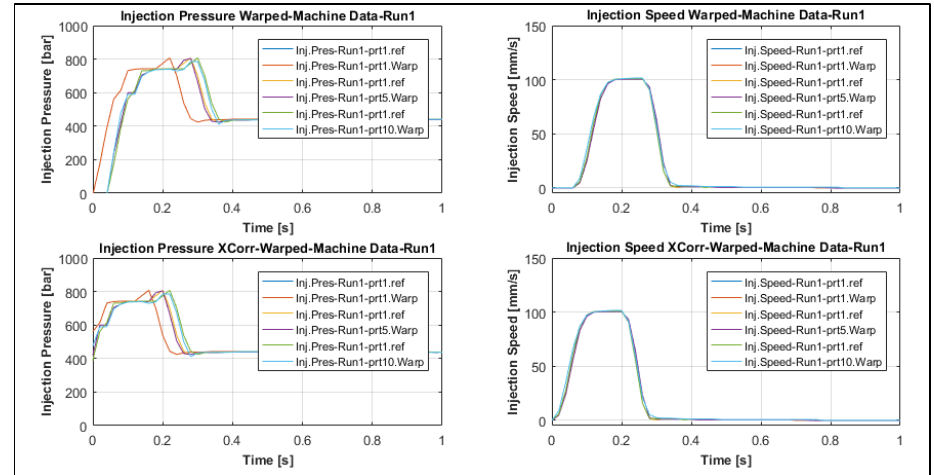
Figure 11. Alignment of original ( top ) and cross-correlated ( bottom ) signals of injection speed and pressure of Run 1 and part c ycles 1, 5, and 10 using dynamic time warping (DTW). To ensure the validity of the previously introduced QIs, the QI values were not directly comparable to the dimensional measurements of the micro-feature on the collected samples, and the data were standardized using Equation (12).